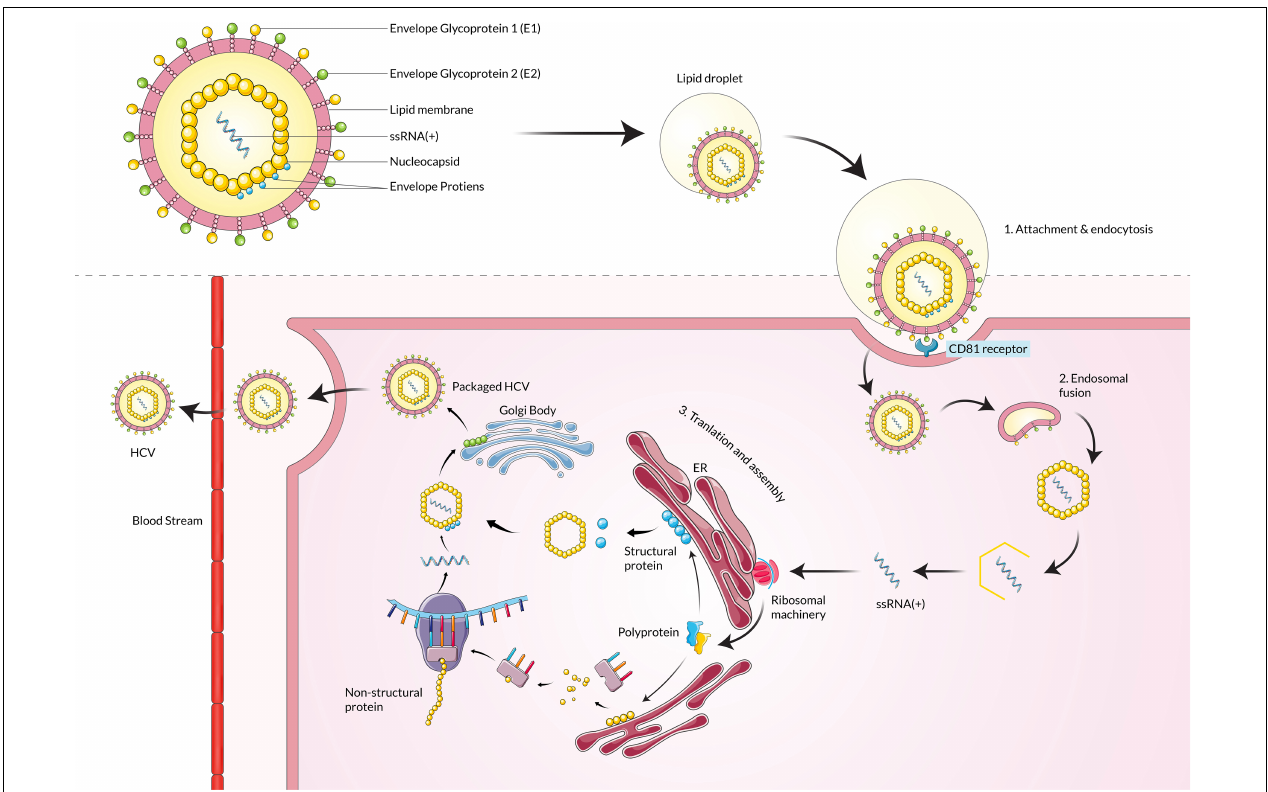
FIGURE 3 | Hepatitis C virus particle binds with the CD81 receptor, fuses with the membrane, and enters the host cell. Upon entering, the ssRNA(+) is translated by ribosomal machinery and produces both structural and non-structural proteins, which assemble and mature in the Golgi body and are then released into extracellular space.